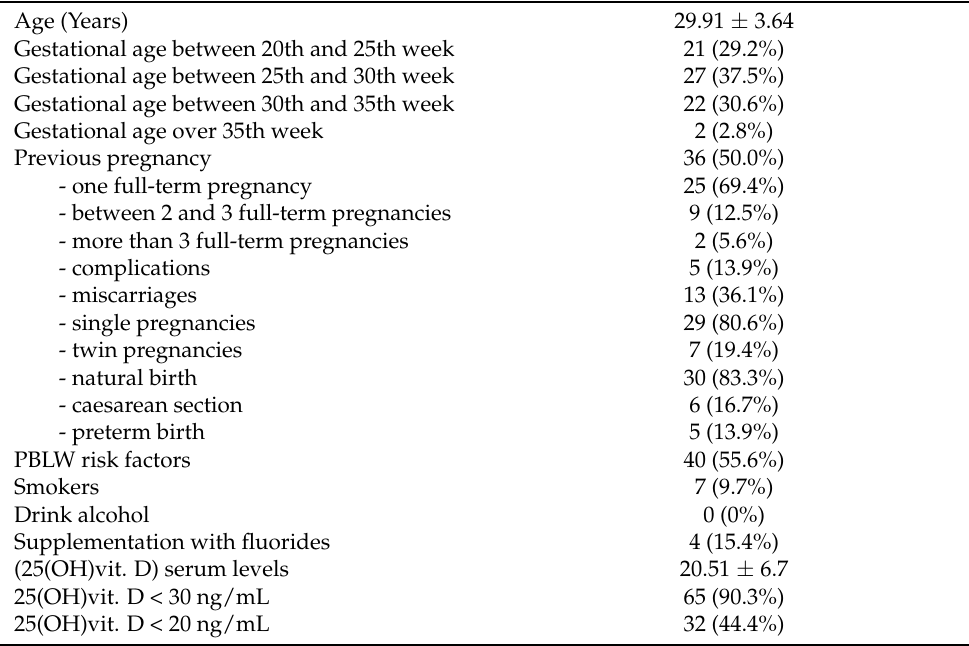
Table 1. Anamnestic and clinical characteristics of the study participants ( n = 72).